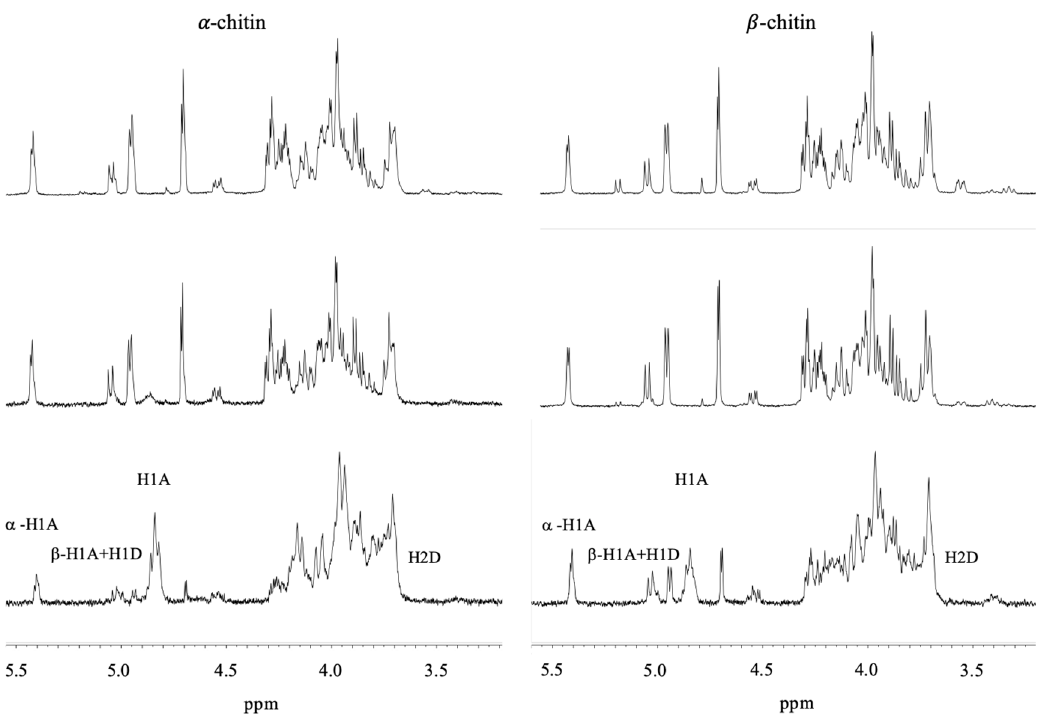
Figure 1. 1 H NMR spectrum of untreated α -chitin (bottom left, F A = 0.950) and β -chitin ( bottom right , F A = 0.895) nanofibers before addition of Vc CDA and after 24 h ( α -chitin middle left , F A = 0.945) and ( β -chitin middle right , F A = 0.873), and 48 h ( α -chitin middle left , F A = 0.898) and ( β -chitin middle right , F A = 0.852) of incubation with Vc CDA. The peaks of β H1 and H1D come at ppm of 5.05 and 5.07, respectively, H1A comes at ppm 4.91, and H2D comes at ppm 3.44 [16].